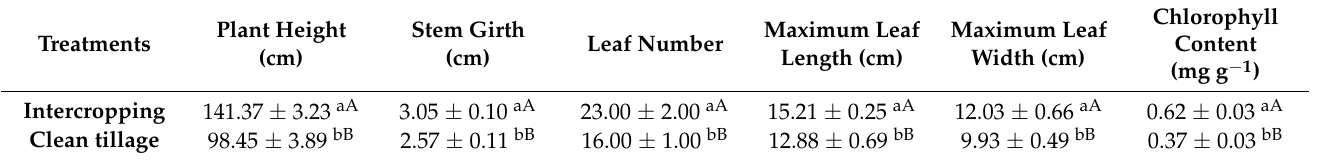
Table 3. Effects of intercropping V. sativa on growth of kiwifruit